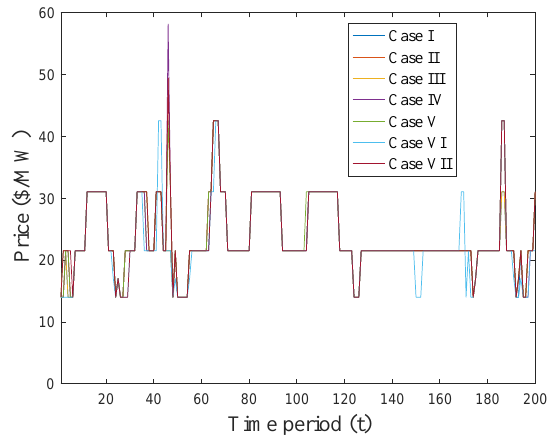
Figure 6. Electricity prices over the study time period for deterministic Cases